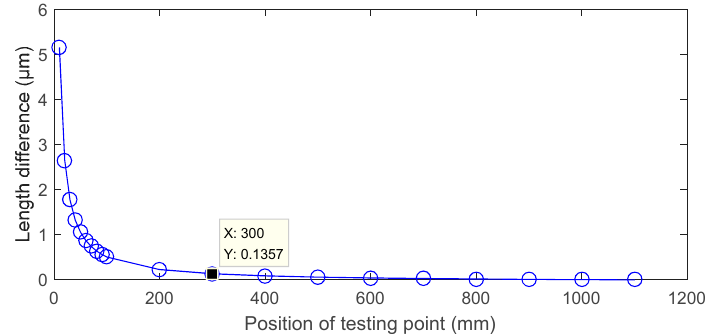
Figure 12. Simulation result of measurement length difference ( x -axis).